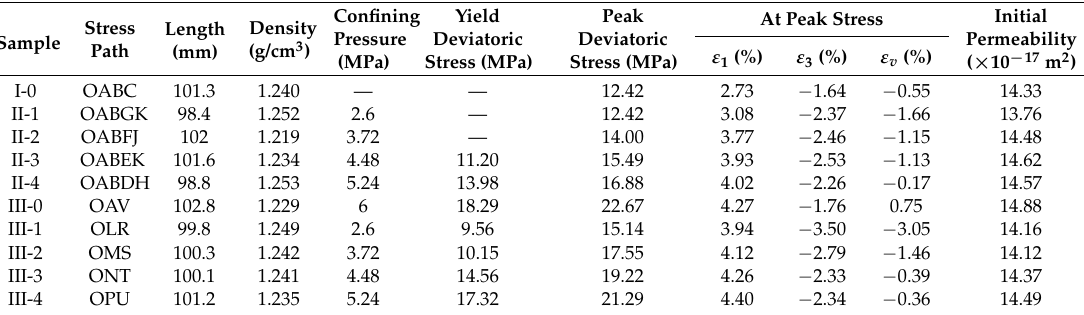
Table 3. Sample sizes and experimental parameters.